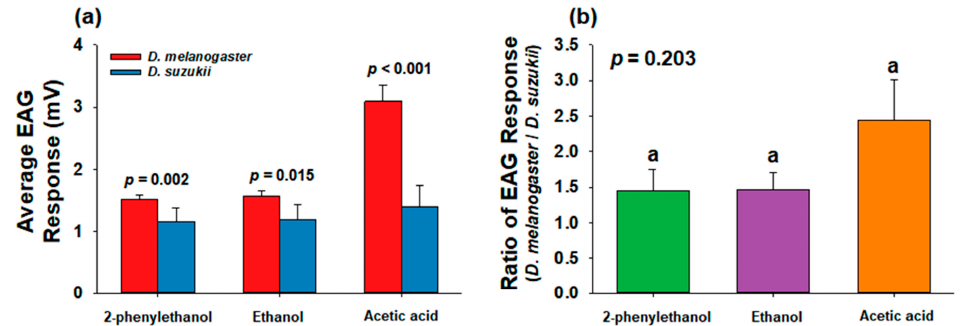
Figure 3. Comparison of ( a ) integrated EAG response values between Drosophila melanogaster and Drosophila suzukii and ( b ) ratio of EAG response values between two flies ( D. melanogaster / D. suzukii ). Student’s t -test was used to compare the ( a ) average EAG values between the two fly species ( p < 0.05) and ( b ) ratios of EAG response value were statistically analyzed using one-way ANOVA. Data are presented as the mean ± standard error. EAG, electroantennogram.